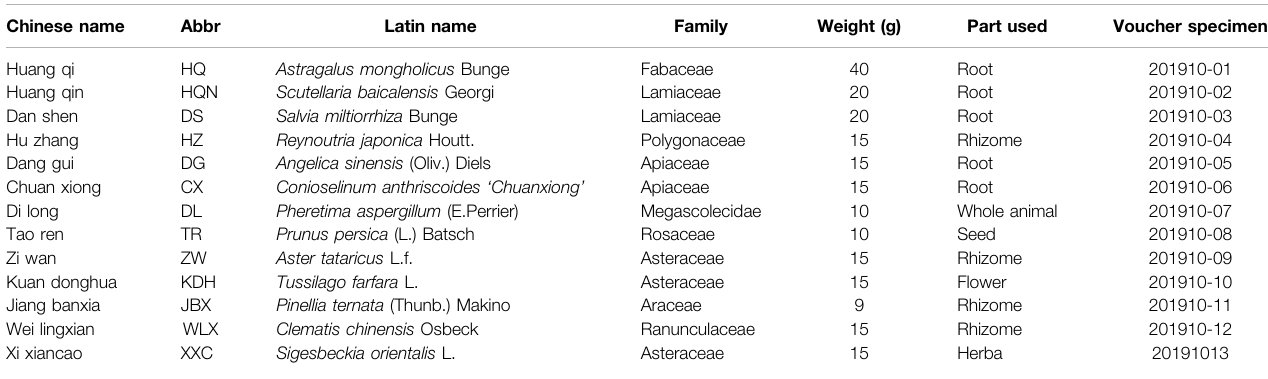
TABLE 1 | The compositions of WBT